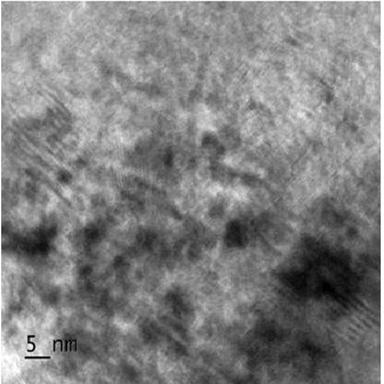
TEM images of RbCl-doped MgO nanomaterial (i) with the resolution of 20 nm and (ii) with the resolution of 5 nm.